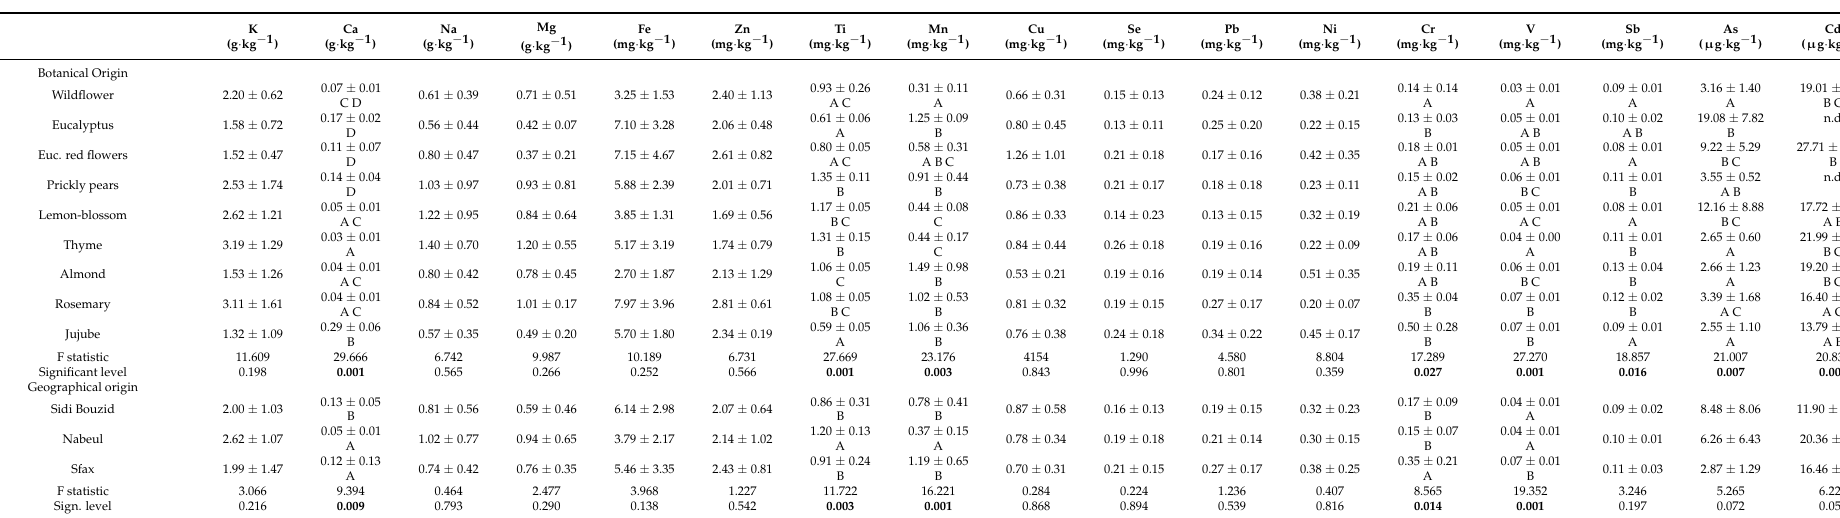
Table 3. Mineral contents (mean ± standard deviation) for Tunisian honey samples and results of Kruskal–Wallis test for honey samples categorized by their botanical and geographical